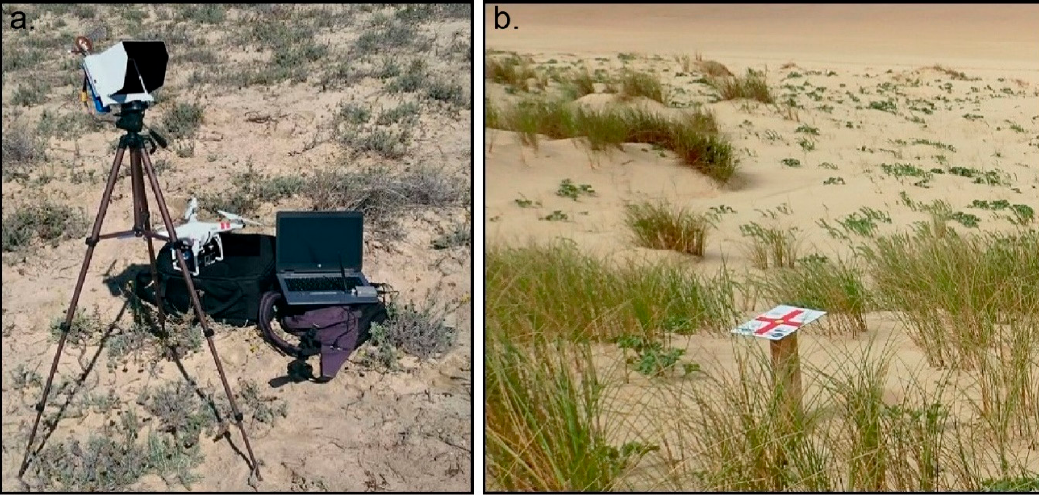
Figure 2. The dune survey system composed of ( a ) light and low-cost UAV hardware, computer ground station, video receiver, and ( b ) permanent GCPs spaced every 250 m and approximately 50–100 m in the alongshore and cross-shore directions, respectively.